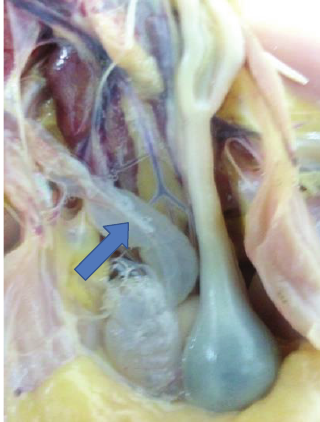
Figure 7: Cystic oviduct in 11-week-old chicken experimentally infected with a CR88 infectious bronchitis virus strain. Note the distention of the entire oviduct and fluid accumulation (arrow).